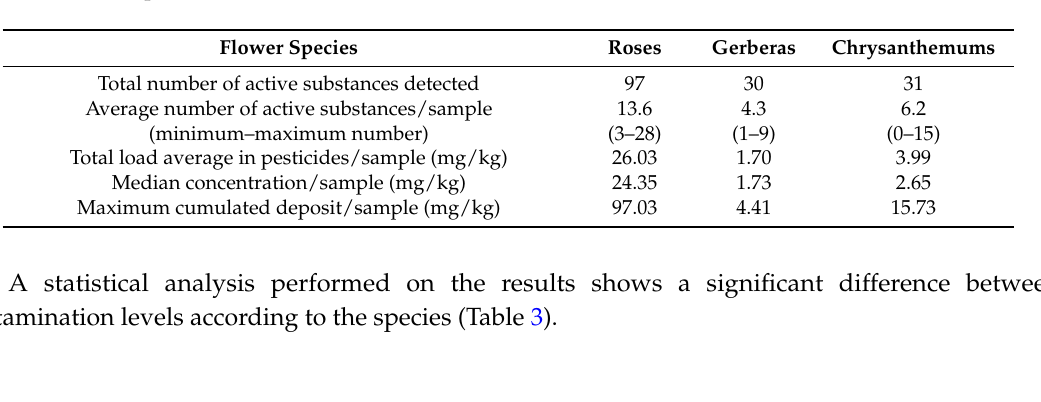
Table 2. Total number of active substances (a.s.) detected, average number of a.s. per sample (min-max), average total concentration of residues (mg/kg), median concentration, and maximum cumulated deposit (sample with the highest total amount of pesticide residues, in mg/kg) observed on a bouquet, for the three